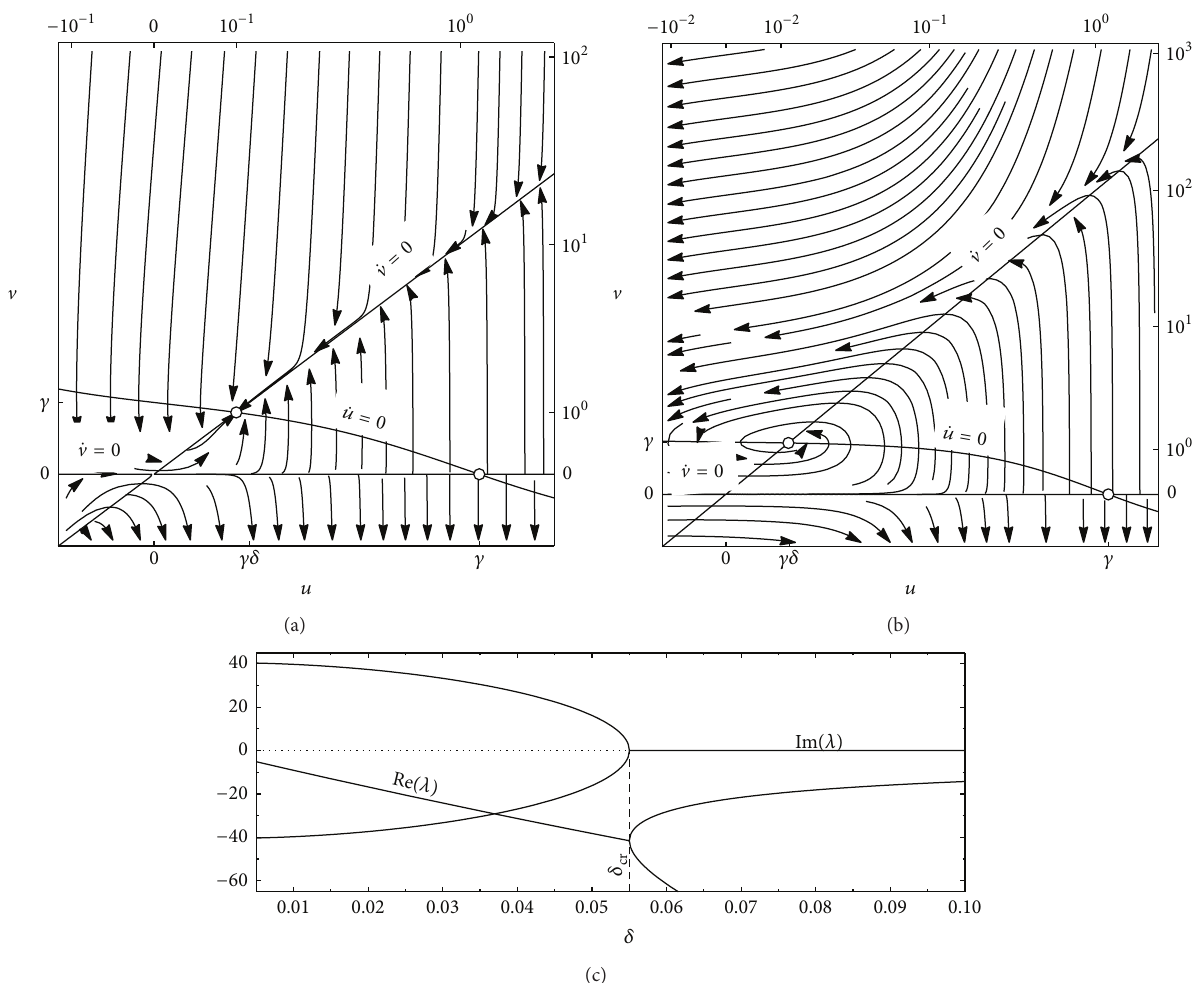
Figure 1: Phase portraits of an isolated CR system (2a) and (2b) for two cases when the unique stable equilibrium (3b) is a node (a), and a focus (b). Shown are vertical ( ̇𝑢 = 0 ) and horizontal ( ̇ V = 0 ) nullclines. Steady states are marked by open circles. Numerical simulations have been carried out with data from Table 2. The respective values of the second order loss parameter 𝛿 in (a) and (b) are 0.1 and 0.01 . Typically, consumer scale ( V ) is enormous; the equilibrium point happens to lie very close to the origin. For better appearance, henceforward we display all the graphs using coordinate transformation 𝑢 → arsinh (𝑢/𝛾𝛿) and V → arsinh ( V /𝛾) . (c) Eigenvalues of (4) at (3b) as a function of the indicates a boundary between the regions of damped oscillations and aperiodic second order loss 𝛿 . Critical value 𝛿 cr